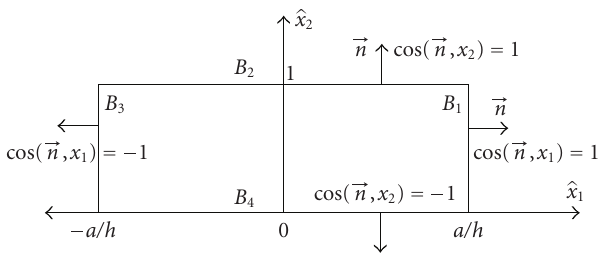
Figure 3.1 . The form of the boundary ∂ (cid:12) B